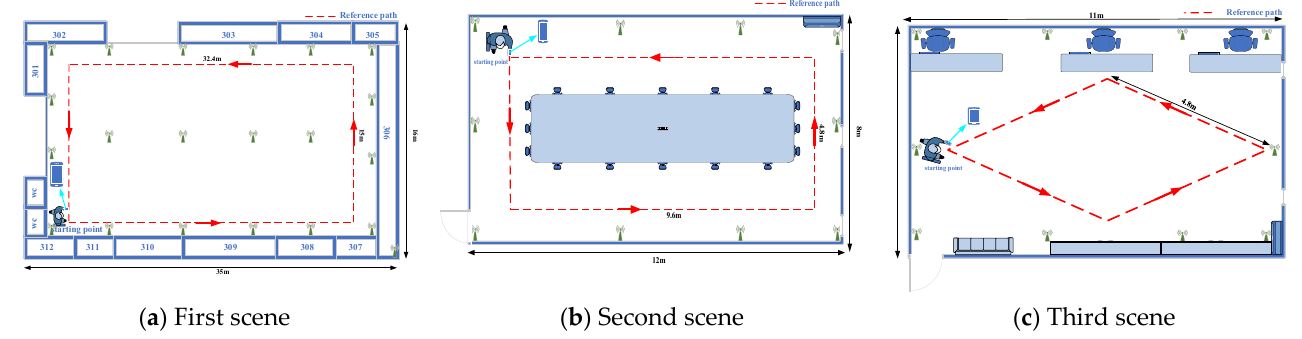
Figure 8. Floorplans of the experimental sites: ( a ) scene 1 with open spaces, ( b ) scene 2 includes small spaces with some tables and chairs, ( c ) scene 3 includes small spaces with some tables, chairs and cabinet.